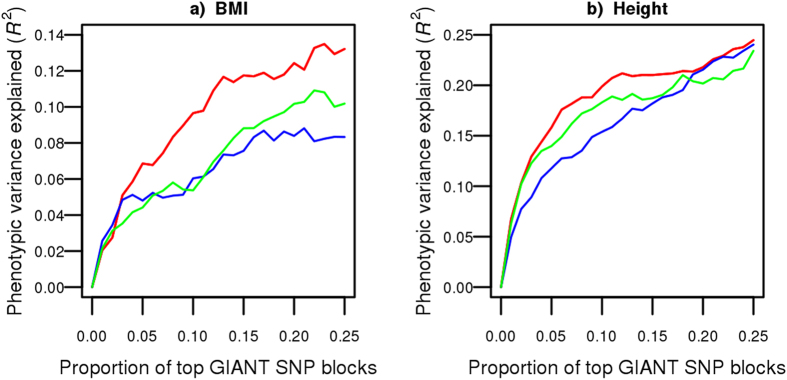
Genetic variance as a function of proportion of top SNP blocks.Genetic variance in HRS based on SNP block ranking derived from GIANT summary association statistics. Three methods were tested to rank SNP blocks: LARGV (red), LD Score (blue) and multi-SNP locus-association (green). The median SNP block size was 250 Kb (i.e. 85–95 SNPs). Genetic variance was calculated in HRS using variance component models for BMI (a) and height (b).